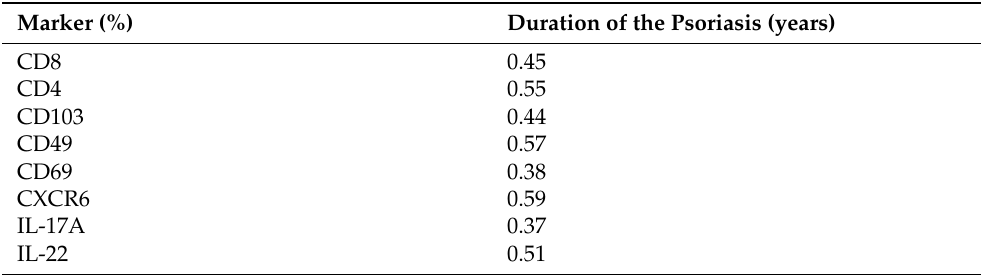
Table 3. Correlations (r, p < 0.05) between individual markers and the duration of psoriatic lesions.